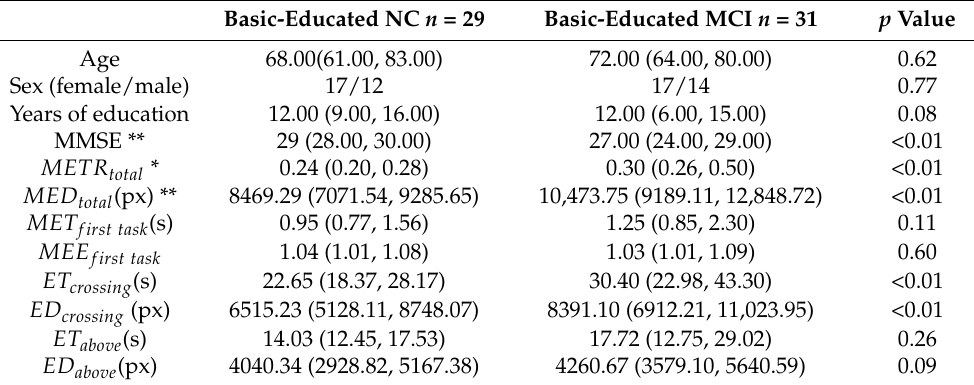
Table 5. Participant demographics and differential analysis of digital biomarkers and MMSE scores between the NC and MCI groups with basic education.